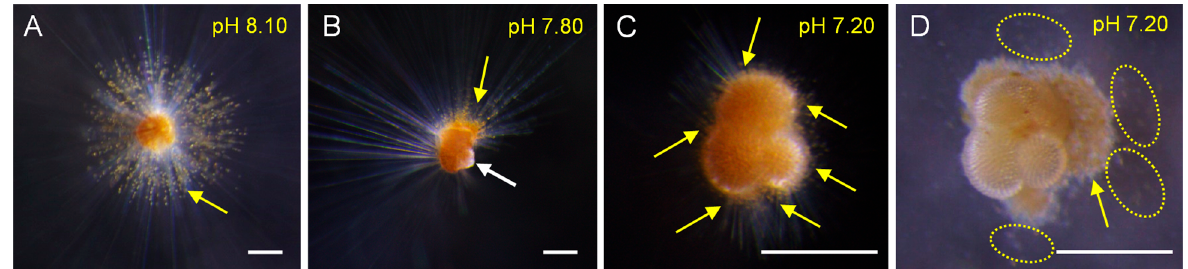
Figure 3. Variations of symbionts in living T. sacculifer under different pH conditions. ( A ) Many symbiotic dinoflagellates were dispersed among their long pseudopodia under the pH 8.10 conditions (the brown particles identified by the yellow arrows are symbiotic dinoflagellates, i.e., zooxanthellae). ( B ) Only a small number of symbiotic dinoflagellates gathered at the roots of the pseudopodia under the pH 7.80 conditions. The yellow arrow shows the gathered symbionts, while the white arrow shows the loss of pseudopodia and the partly empty chamber. ( C , D ) Loss of symbiotic dinoflagellates in a living T. sacculifer from the same specimen under the pH 7.20 conditions. At first, the symbiotic dinoflagellates were distributed around the shell, as indicated in panel C, with yellow arrows indicating the symbiotic dinoflagellates. Then, the pseudopodia and symbiotic dinoflagellates gradually disappeared, and some of the remaining symbionts gathered together, as indicated in panel D, with the yellow arrow showing the gathered symbiont, while the yellow circles show the symbionts that separated from the host. Scale bar = 200 μ m.